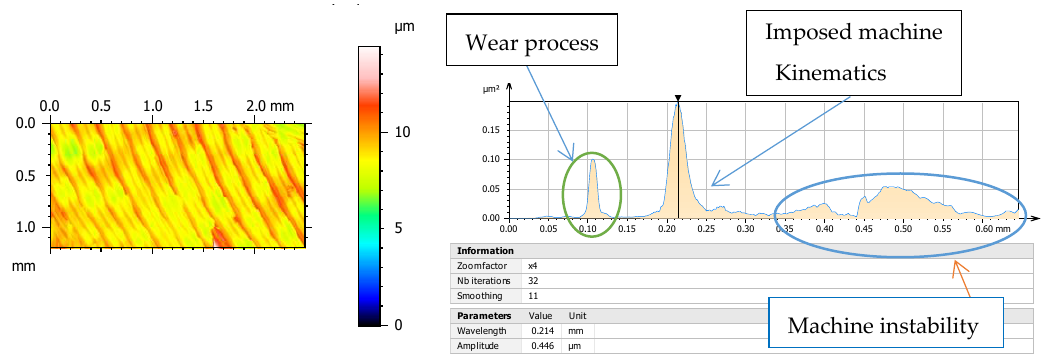
Figure 1. Power spectral density (PSD) function offers the possibility of quantitative identification of certain motifs, the periodicity, and their orientation from 3D analysis.